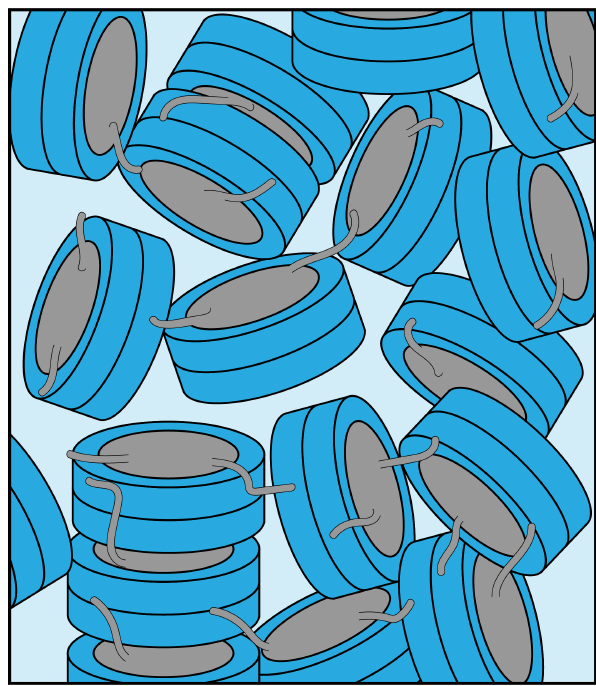
Figure 5. Schematic illustration of the packing in the nucleosome sediment obtained by ultracentrifugation. The packing density in the schematic corresponds to our experimental estimate ( ∼ 61%), while the heterogenous orientation of nucleosomes in the sediment reflects the lack of strong long order in the sample. Nucleosome– nucleosome interactions are predominantly formed by histone tail– DNA